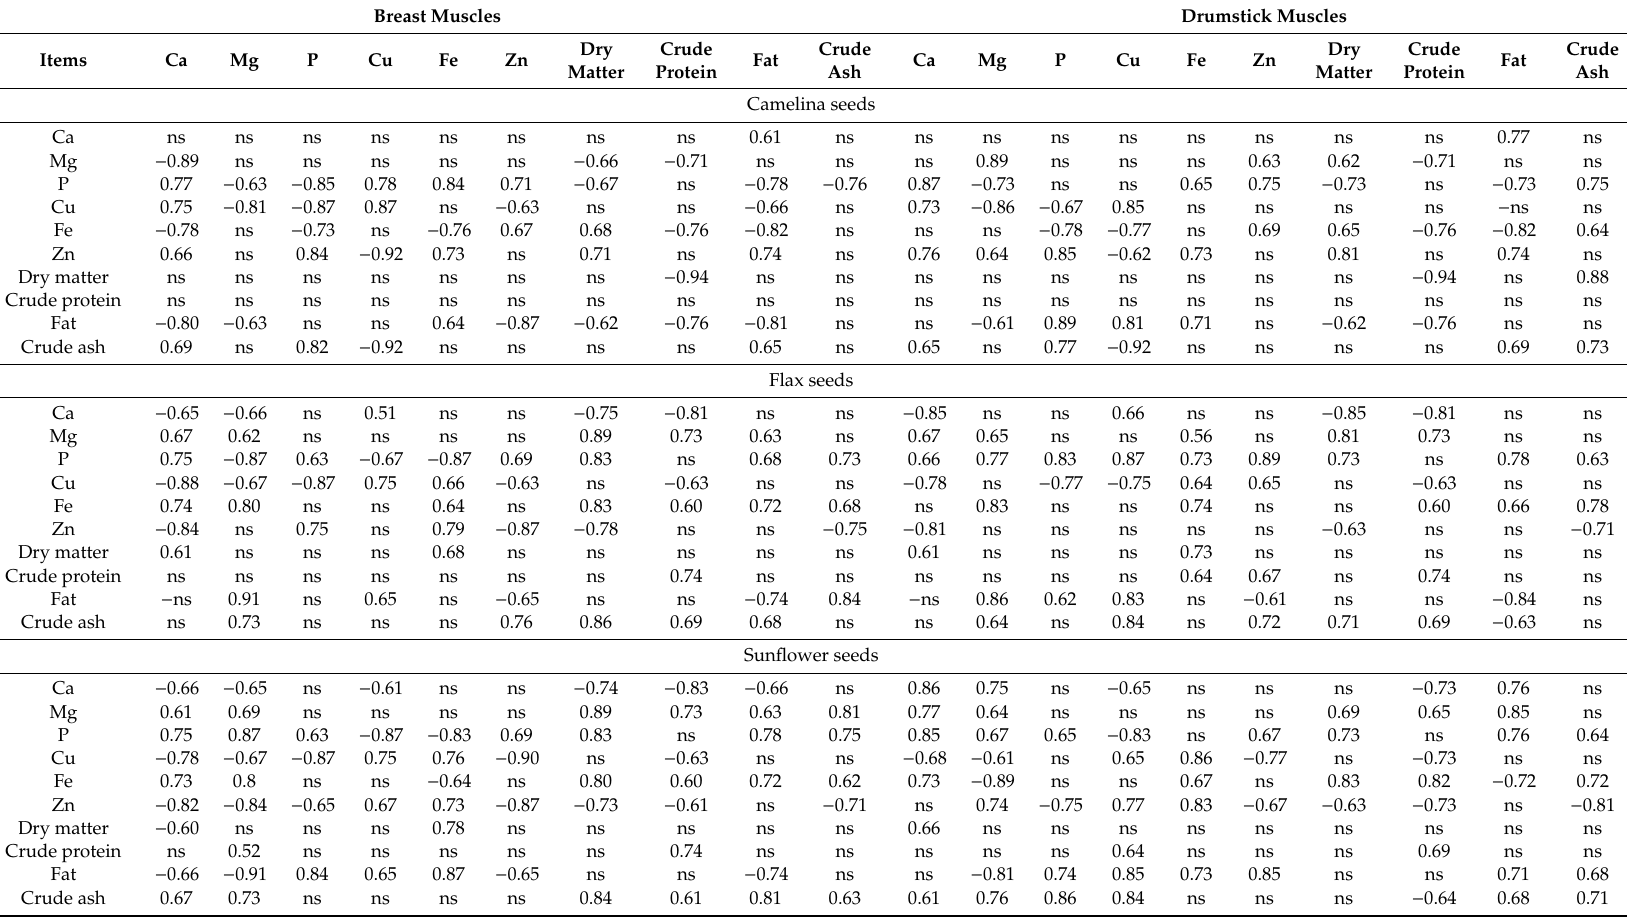
Table 6. Correlation coe ffi cients between basic nutrients and mineral elements in the camelina, flax, and sunflower seeds and the breast and drumstick muscles of broiler chickens fed a control, camelina, flax, and sunflower diet (r) 1